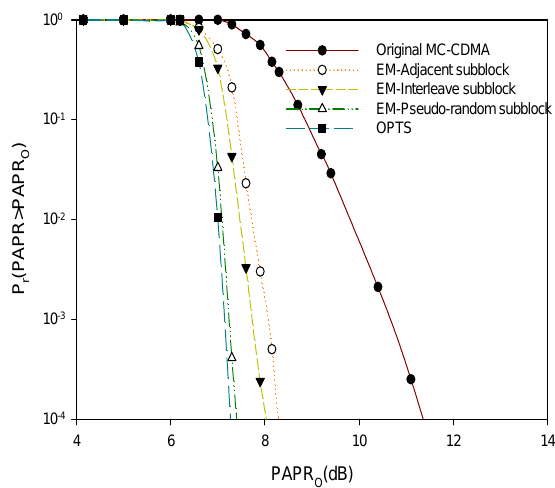
Fig. 4 CCDF of the sub-block phase weighting using three partitioning